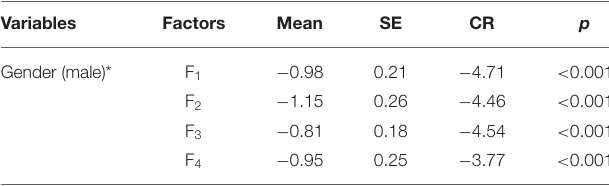
TABLE 5 | Group mean differences in latent